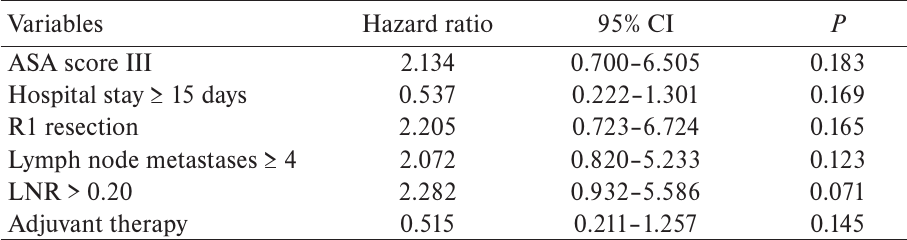
Table 3. Univariable analysis of clinicopathological and histopathological risk factors on overall survival of patients after resection for distal